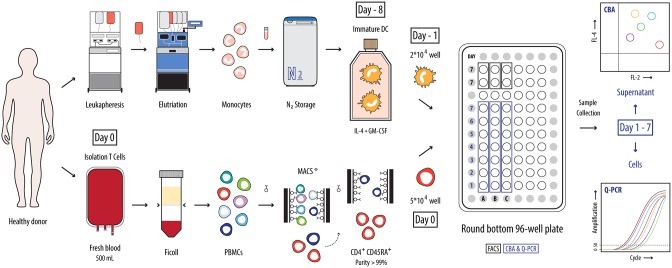
Schematic representation of the APC-dependent assay to monitor DC-induced naive CD4+ T cell polarization.Monocytes were isolated from leukapheresis products obtained from healthy volunteers by counter flow centrifugal elutriation. These enriched monocytes (purity 87.9%±5.2) were frozen and upon thawing differentiated into iDC using IL-4 and GM-CSF. After 7 days, iDC were harvested and plated in a round bottom 96-well plate (2×104 cells/well) in presence of maturation stimuli (A–C). The following day, autologous naive CD4+ T cells were isolated from fresh PBMC obtained from 500 ml of blood by negative immunomagnetic separation (purity of 99.9% of total CD4+ T cells) and 5×104 T cells were added to the different wells, preceded by a 1-hour incubation with PADRE, a pan HLA-DR-restricted peptide. The co-culture was maintained over a period of 7 days and each day supernatant and cells of a single well of each condition were harvested to analyze the secretion of Th-specific cytokines (CBA) and the expression of Th-related transcription factors and cytokines (qPCR).